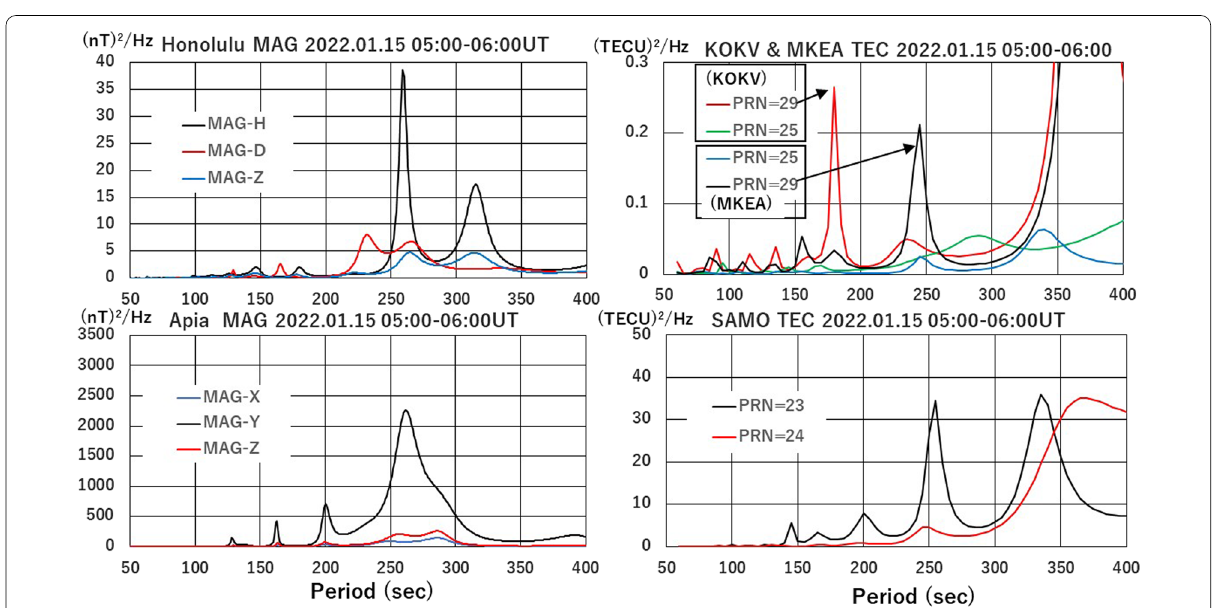
Fig. 8 Same as Fig. 7, but with the data from 05:00 to 06:00